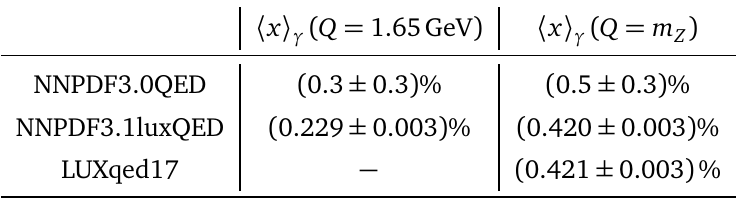
Table 3.1: The momentum fraction 〈 x 〉 γ carried by photons in the proton, Eq. (3.1), at